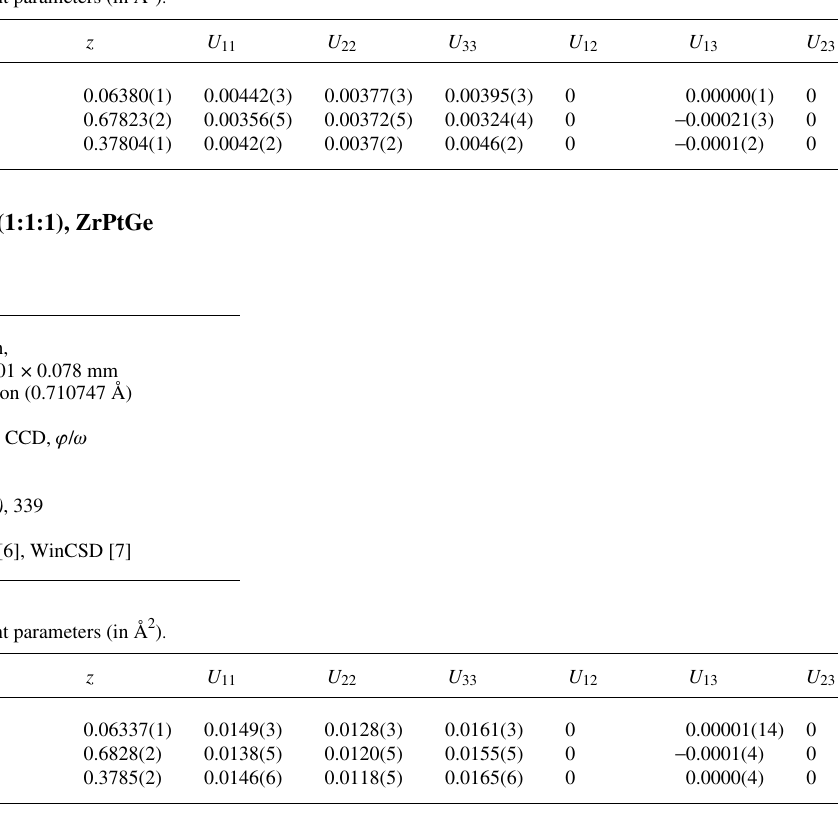
Table 2. Atomic coordinates and displacement parameters (in Å 2 ) .